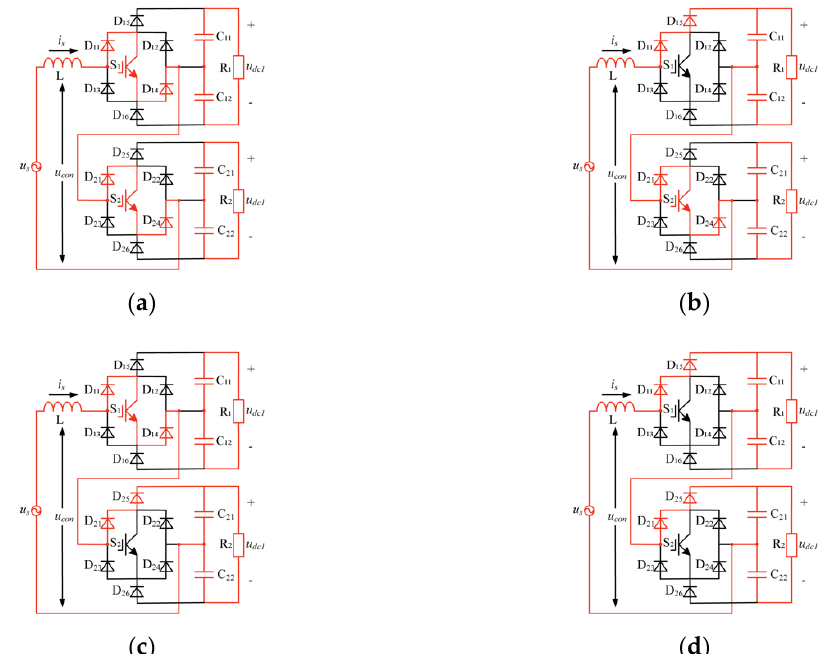
Figure 7. Current paths of the four operation modes for cascaded VIENNA rectifier; ( a ) Mode I; ( b ) Mode II; ( c ) Mode III; ( d ) Mode IV.